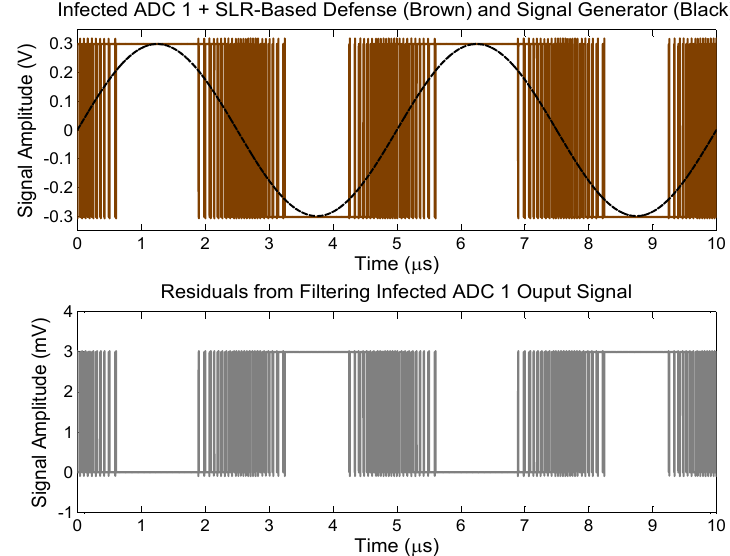
Figure 10. An example of the filtered delta-sigma modulator output signal by the simple linear regression method ( top ) and the residuals from this filtering process ( bottom ). Table 1. Defense Analysis (1): The performance analysis of filters based on their corresponding modified R-squared values when a sinusoidal signal is applied to the